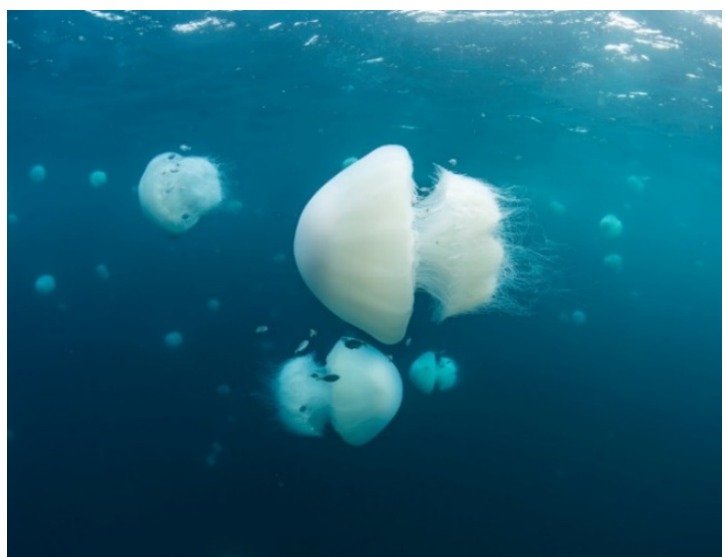
Figure 6. The invasive Lessepsian nomadic jellyfish, Rhopilema nomadica , in the open Mediterranean coastal water of Israel with juvenile slender yellowtail kingfish (photograph by Hagai Nativ).